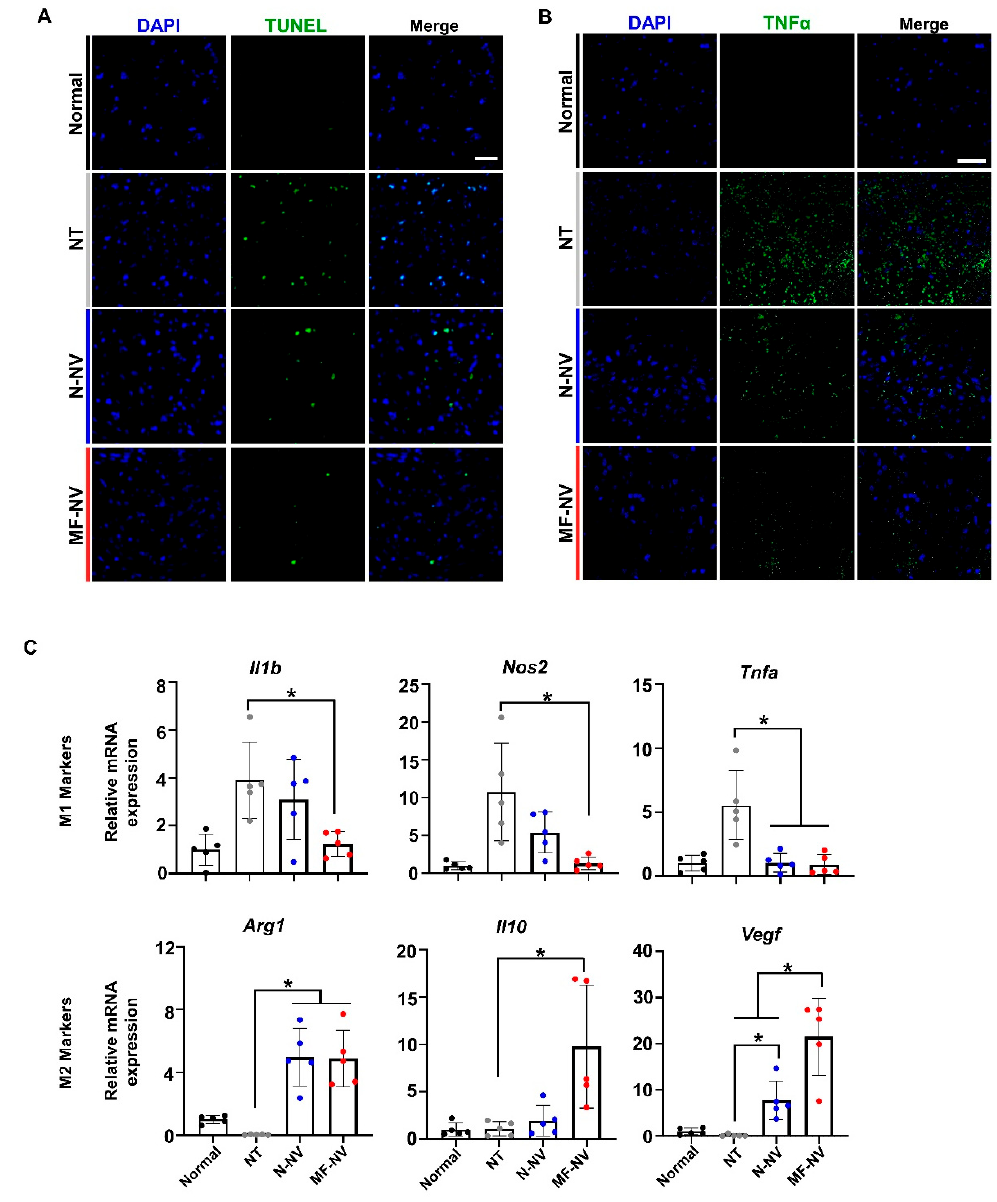
Figure 8. Cont Figure 8. Cont.